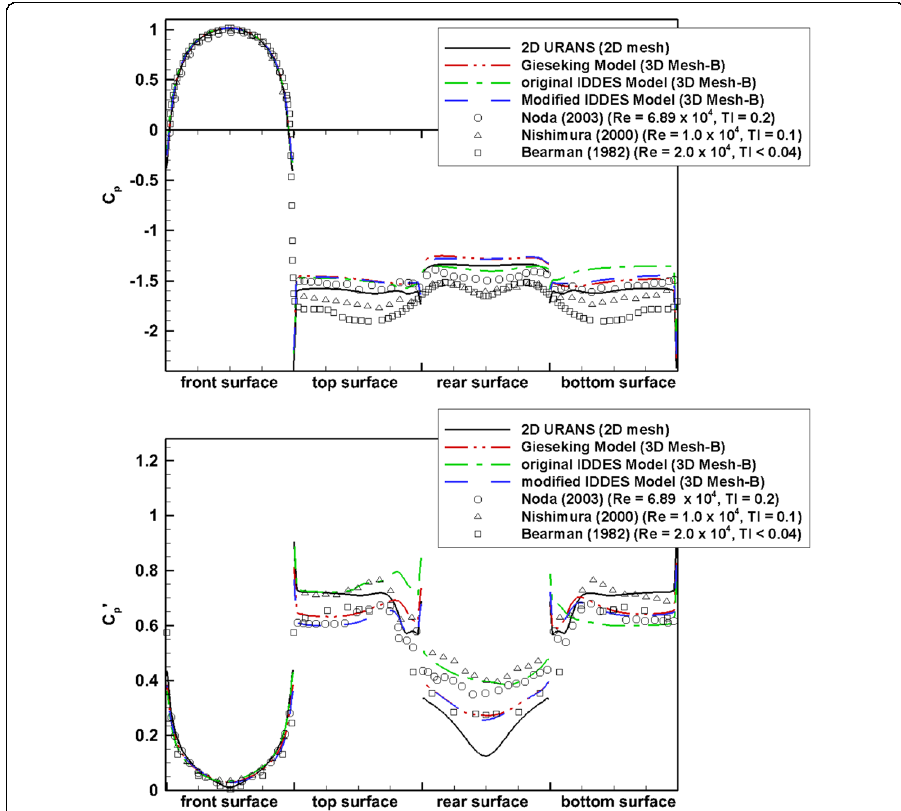
Fig. 2 Surface pressure coefficient distribution (top) and rms pressure coefficient distribution (bottom) predicted by simulations with 3D